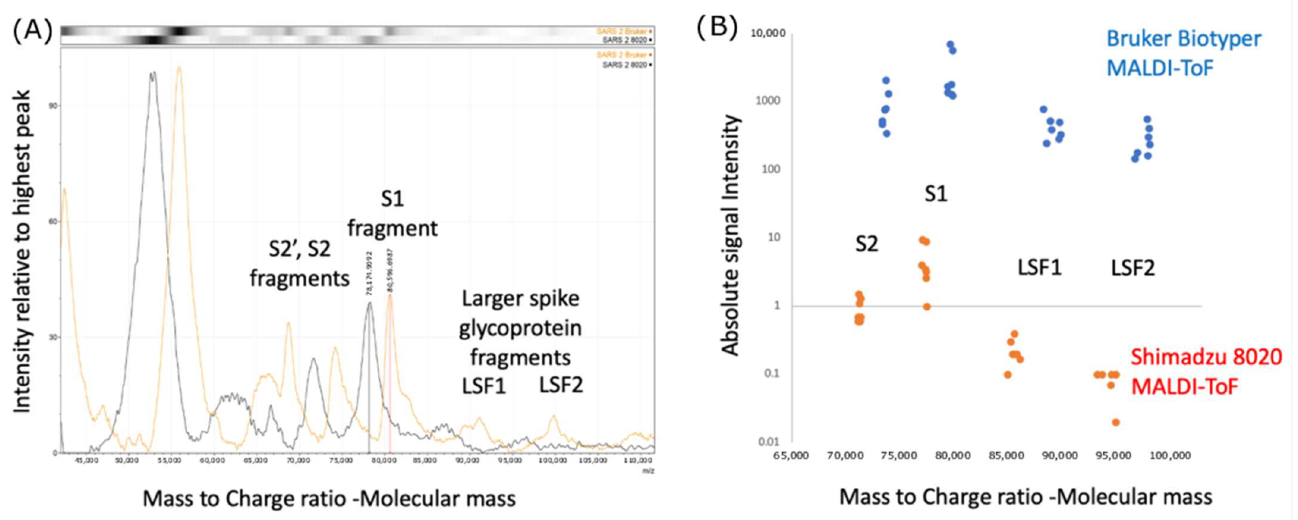
Figure 1. Calibration and Intensity differences Bruker Biotyper versus Shimadzu 8020 mass spectra: ( A ) comparison of peak masses found for Lentiviral pseudotype constructs expressing the Envelope spike protein of the SARS CoV-2 Spike gene. S1—Spike protein proteolytic fragment 1; S2—Spike protein proteolytic fragment 2; S2’ Spike protein proteolytic fragment 2’; LSF—Large spike glycoprotein fragments; Bruker Biotyper—red line spectra; Shimadzu 8020—black line spectra; ( B ) comparison of mass and intensity difference for seven LentiViral pseudotype constructs expressing the Corona Virus’ respective Envelope Spike genes (SARS-CoV-1, SARS-CoV-2, MERS, NL3, OC43, 229E, HKU1). Blue dots—Bruker Biotyper; Orange dots—Shimadzu 802.0. Additionally, by recalibrating the Bruker using bovine serum albumin (BSA) as a analysis of in vitro cultured SARS-CoV-2 (alpha) matched (see Figure 2).